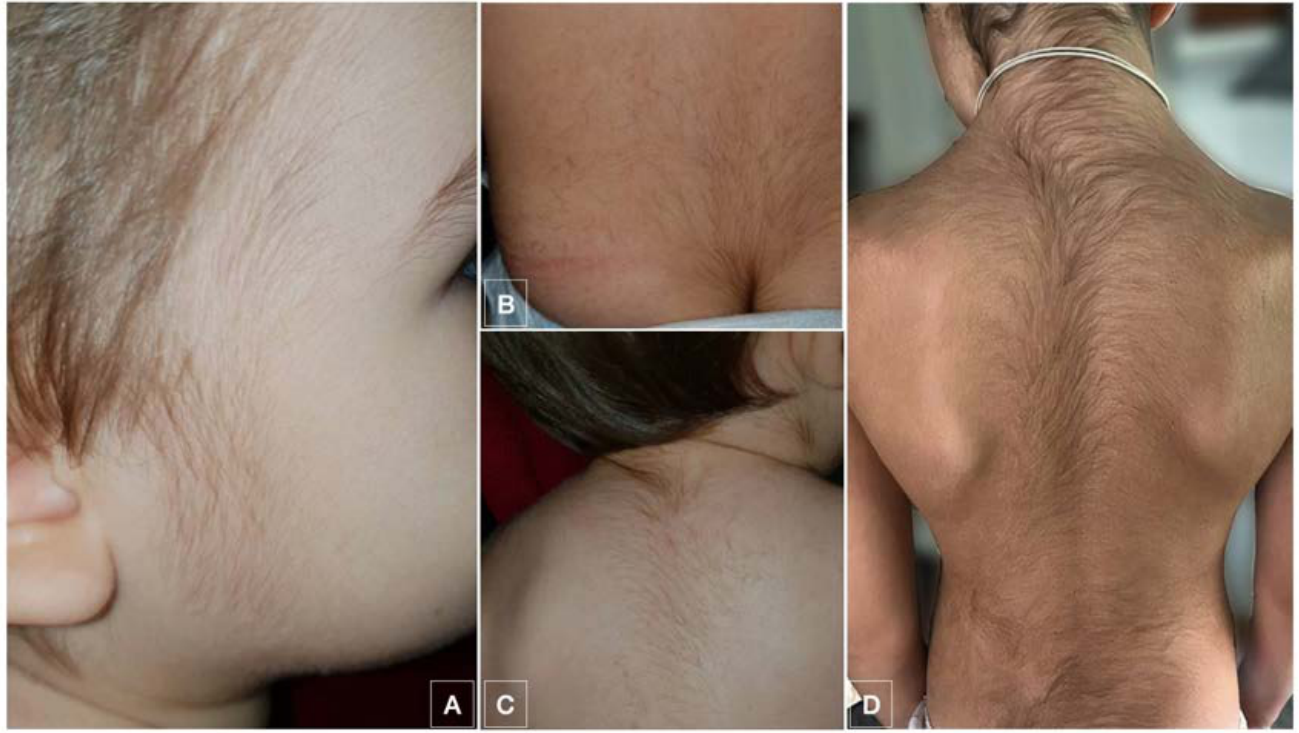
Figure 1. Images showing hypertrichosis which appeared in patient 9 ( A , B , C ) and 15 ( D ). Other skin side effects appeared in 10% (2/20) of the patients: changes in the hyper- trichotic hair colour, appearing lighter hair in one case and darker hair in another. It de- veloped only in the areas affected by the hypertrichosis, with no changes in the colour of the rest of the hair. No cases of Stevens-Johnson Syndrome nor toxic epidermal necrolysis